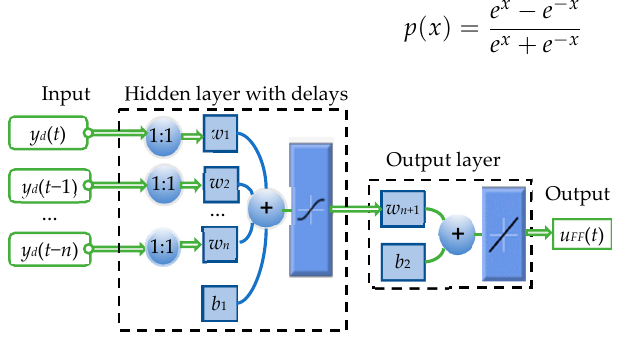
Figure 4. The structure of the multi-layer feedforward neural network (MFNN) for inverse hysteresis modeling.